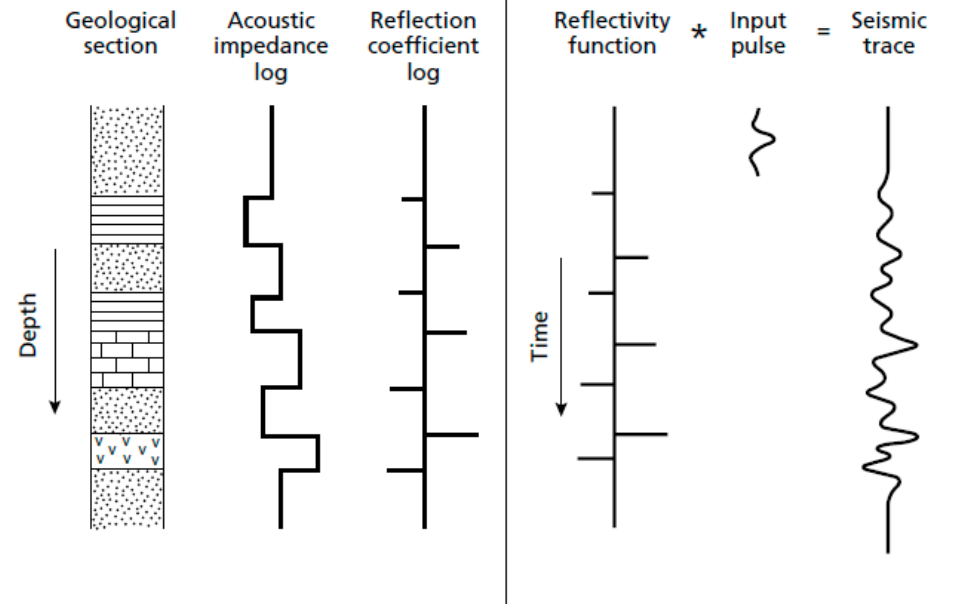
Figure 5. Schematic illustration of the convolutional model.